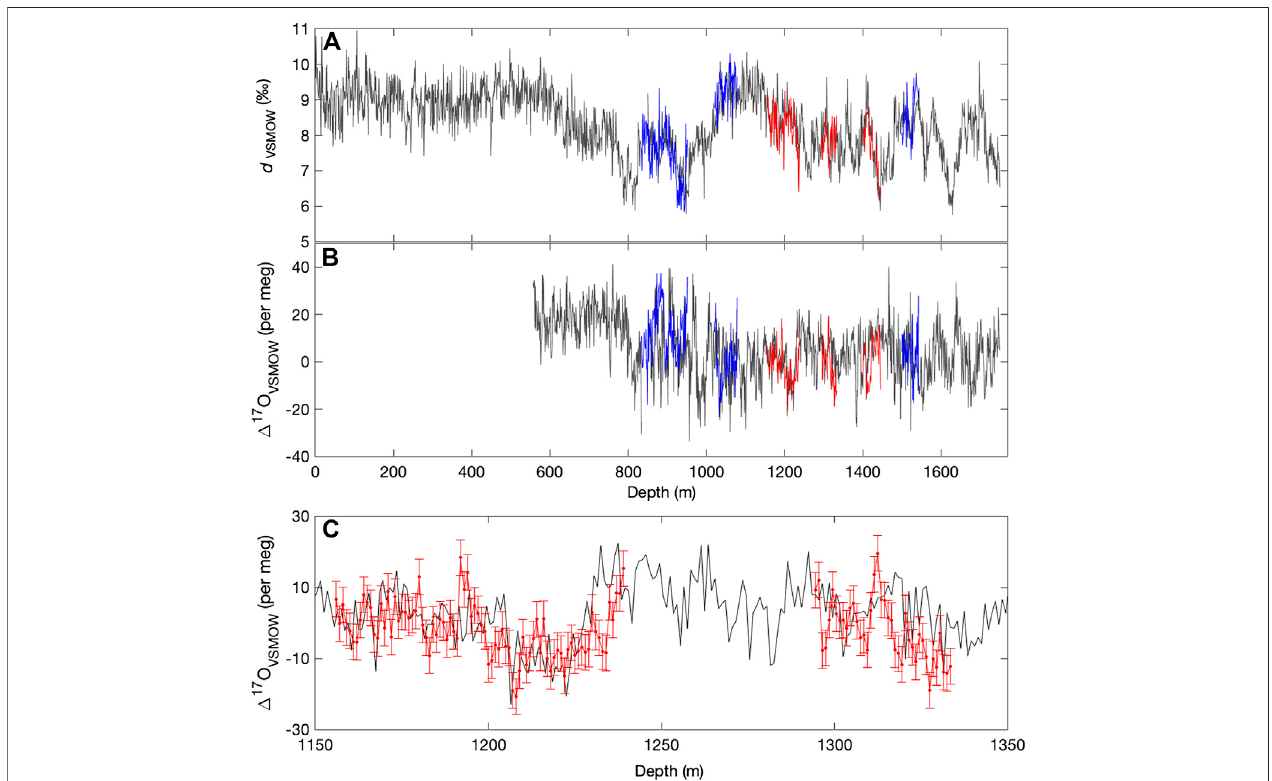
FIGURE5|(A) Deuteriumexcessand (B) Δ 17 OfortheSouth Poleicecore(SPC14),fromcontinuous- fl owmeasurements withthePicarroL2140- i ,calibrated with Eq.10 .Maindatasetingray,withreplicatecontinuous- fl ow(darkblue)anddiscretedata(red). (C) showsanenlargedsectionofdiscretelymeasuredreplicatedata,with 1 standard deviation (10 per meg) error bars. All data are shown as 100 cm averages.